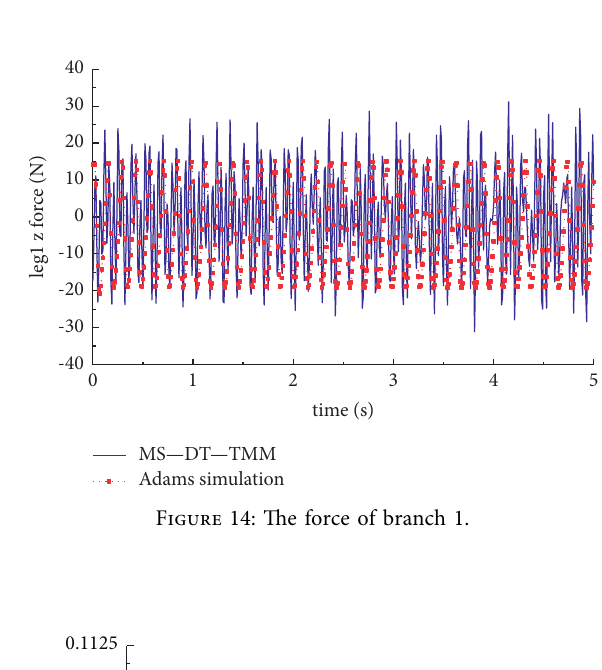
Figure 13: The displacement of branch 1.